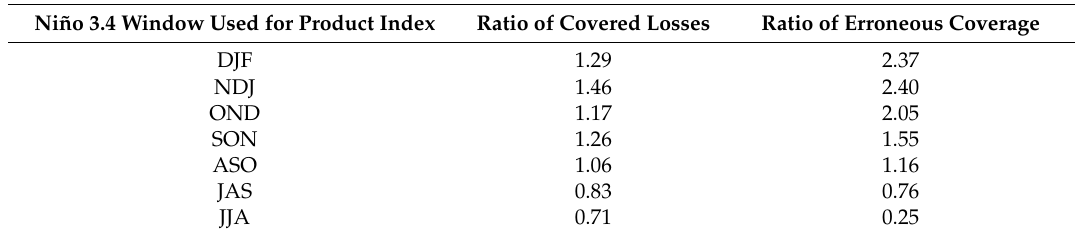
Table 3. Ratios of covered losses and erroneous coverage for products presented in Tables 1 and